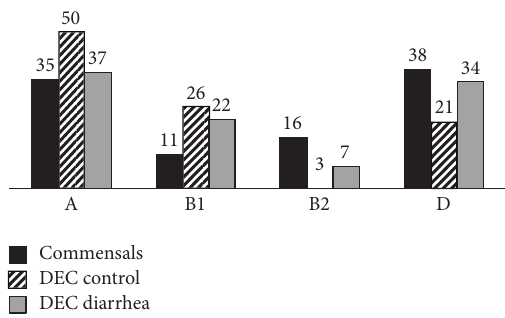
Figure 1: Percentage of phylogenetic groups in commensal E. coli strains ( 𝑛 = 74 ), diarrheagenic E. coli from healthy controls (DEC- control) ( 𝑛 = 94 ), and DEC from children with diarrhea (DEC- diarrhea) ( 𝑛 = 201